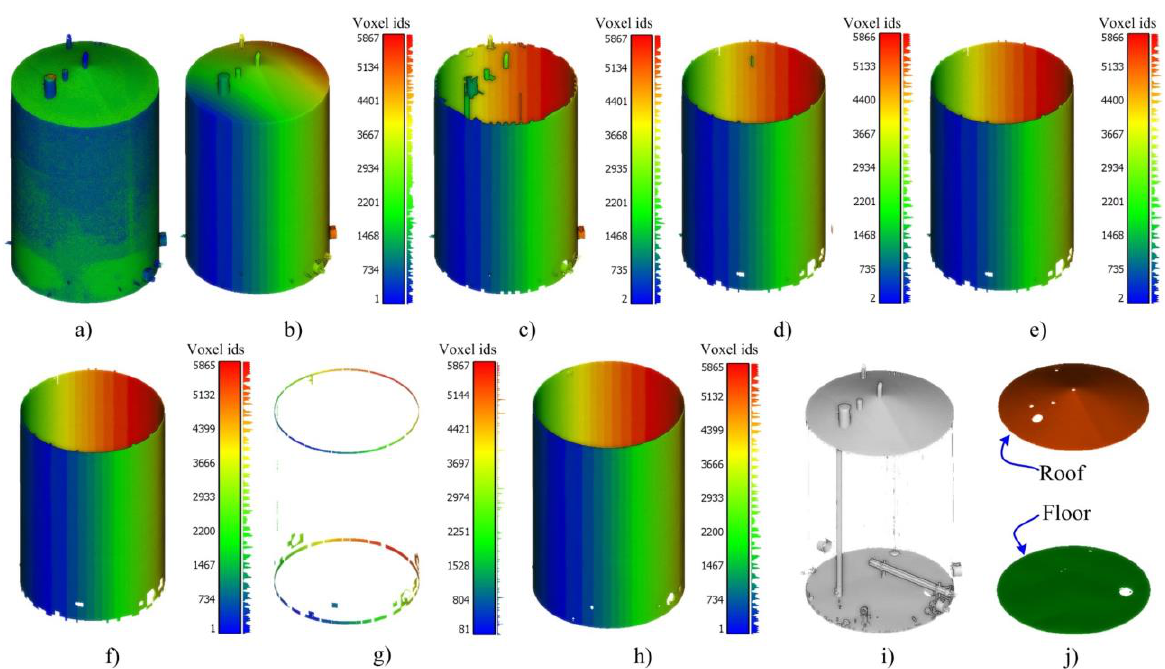
Figure 2 . Extracting a shell wall, roof, and floor of a storage tank from TLS point